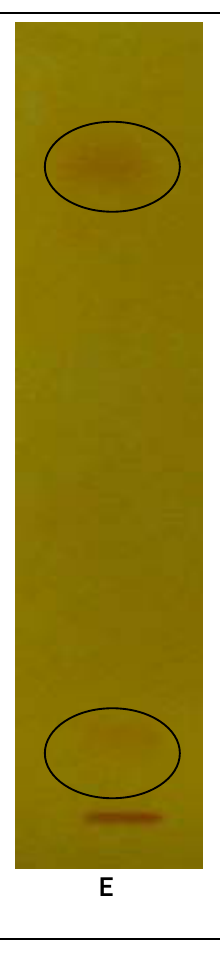
colored spots were visualized after the TLC plate was sprayed with Dragendorff-H indicating the presence of alkaloids. Figure 1. TLC Chromatogram of: (A) aqueous Extract; (B) alkaloid extract; (C) methanolic extract; (D) mitragynine standard, visualized at 365 nm; (E) alkaloid extract visualize by